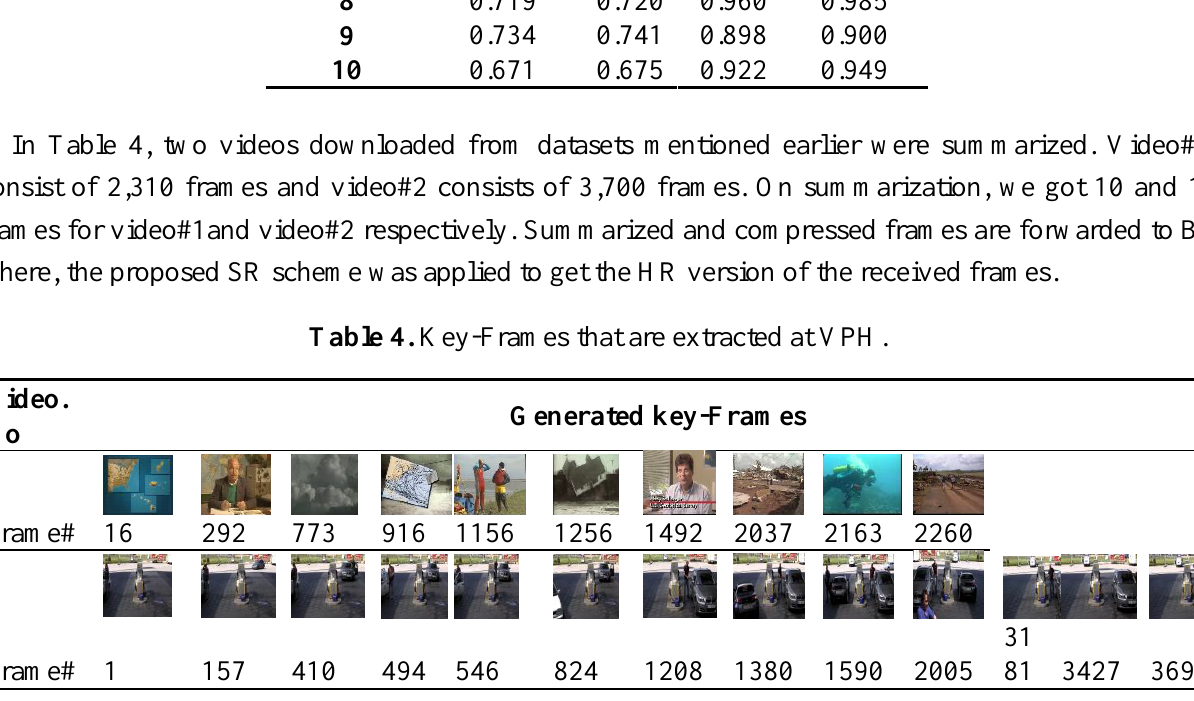
Figure 2. PSNR and MSSIM computed for key-frames of the